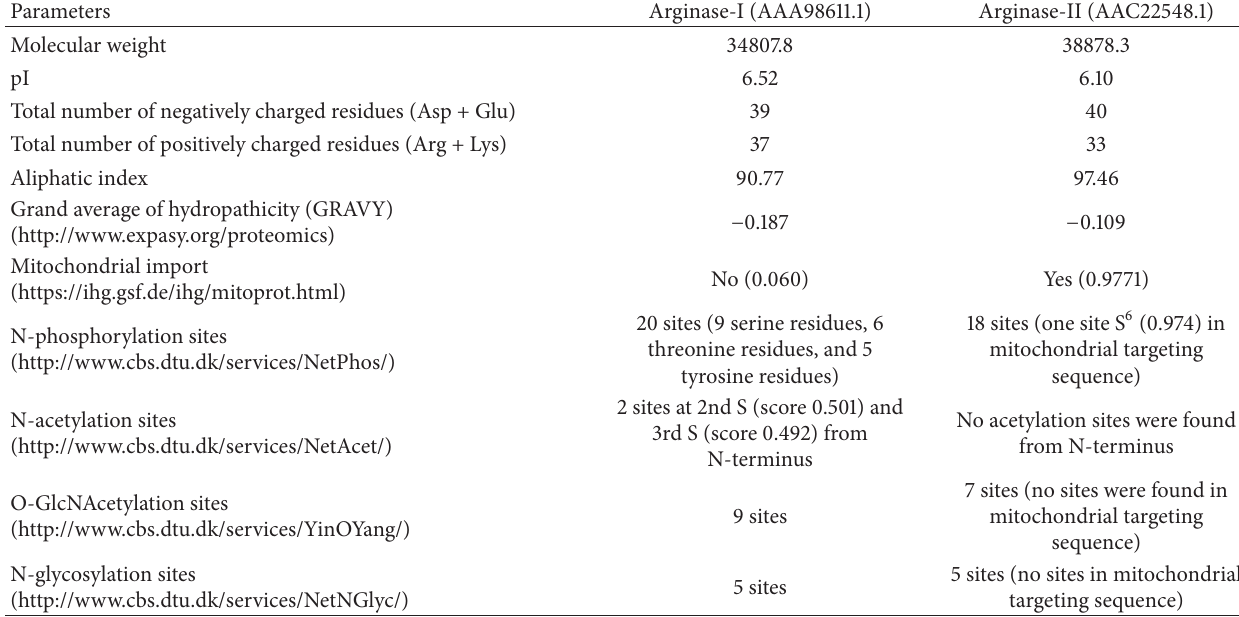
Table 1: Comparative properties of Mus musculus arginase-I and